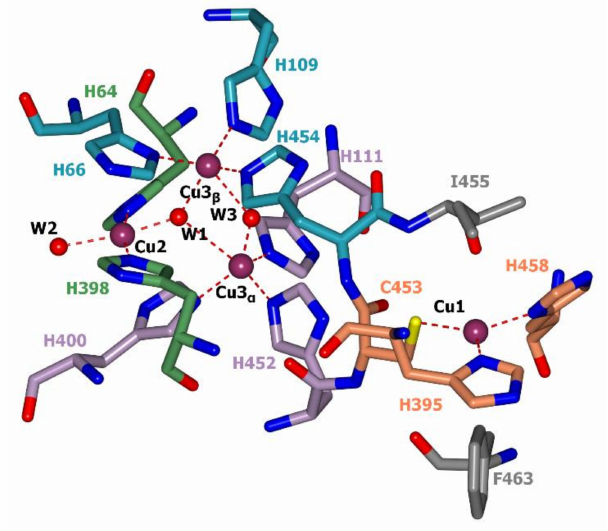
Figure 4. Active center of T. hirsuta laccase (PDB: 3FPX, [61]). Copper ions are shown in purple, oxygen atoms in red, and nitrogen atoms in blue. The carbon atoms of histidine residues coordinating copper ions Cu1, Cu2, Cu3 α , and Cu3 β are shown in coral, green, purple, and blue colors, respectively. Carbon atoms of non-coordinating amino acid residues from the nearest surrounding of the copper ion Cu1 are shown in gray. T2 and T3 water channels are shown with red cylinders and water molecules inside